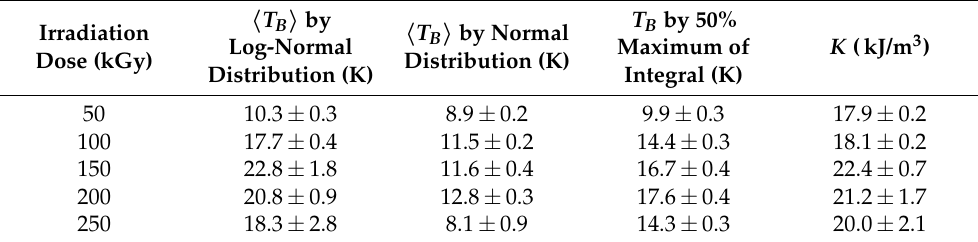
Figure 8. Zero-field cooling and field cooling curves of the 200kGy sample for applied magnetic fields of ( a ) 1.6kA/m, ( b ) 4kA/m, ( c ) 8kA/m, ( d ) 16kA/m and ( e ) 40kA/m. ( f ) Blocking temperature depending on the applied field. The dashed line shows a fit based on Equation(11) leading to an effective anisotropy constant of K = ( 21.2 ± 1.7 ) kJ/m 3 . Table 2. The blocking temperatures, T B , for an applied field of 40kA/m were determined by a log-normal distribution fit, a normal distribution fit and by taking 50% of the integral maximum, as described in Section 2.4. The latter was used to obtain the effective anisotropy constant K